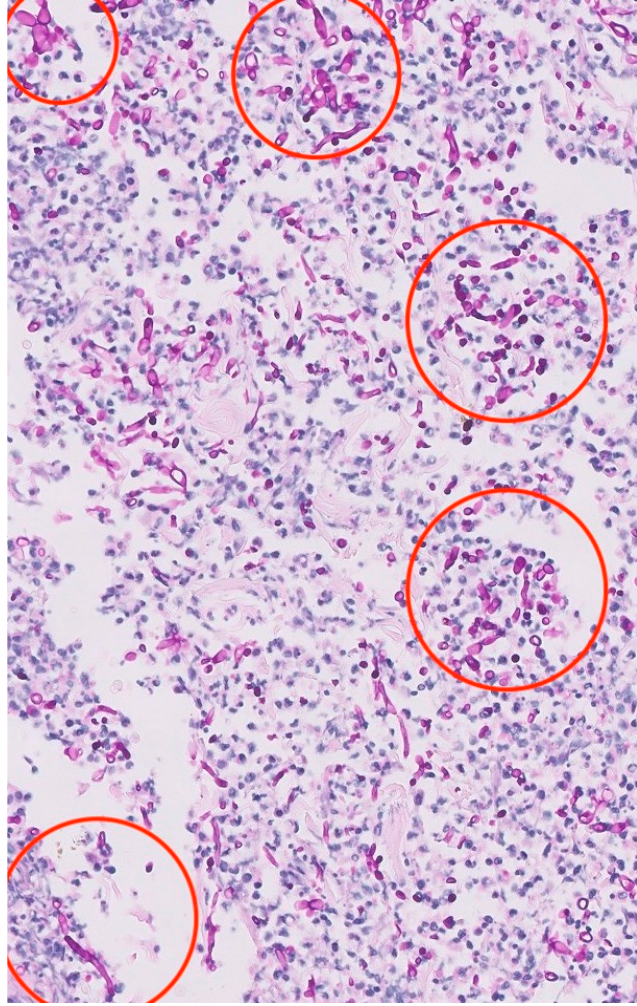
Figure 3. Circled, pseudohyphae observed in skin sample of the lesions on the left leg. PAS staining (60×).